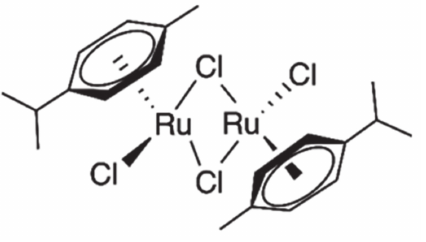
Figure 8. Dichloro( η 6 -p-cymene)ruthenium(II)